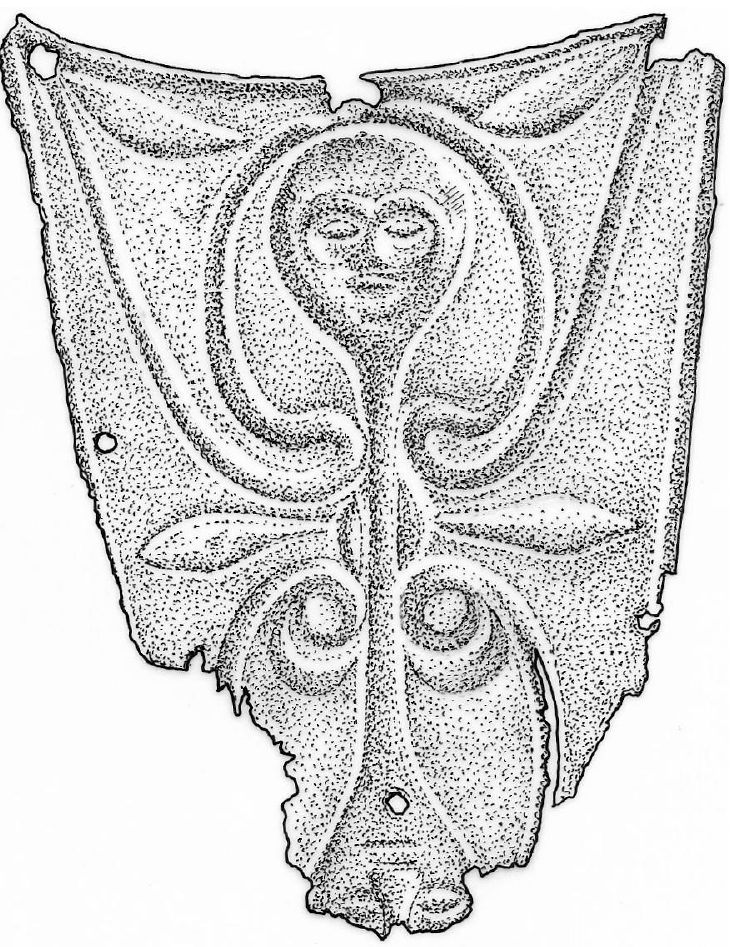
Figure 4. Double-headed plaque from a hoard of late Iron Age or Roman period bronzes, from Tal-y-Llyn, Merionethshire, North Wales, UK. © Nick Griffiths.